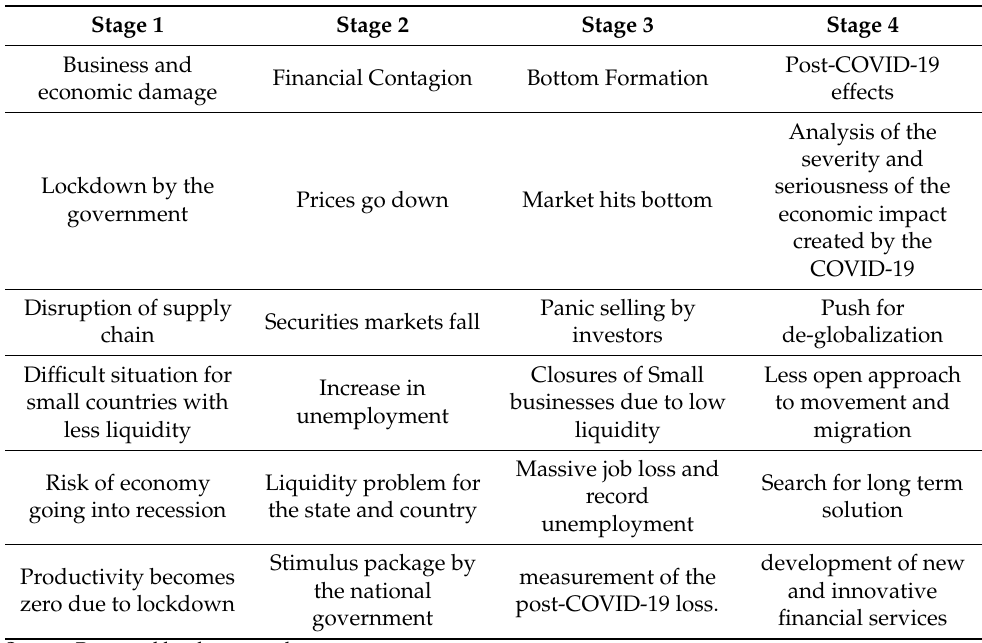
Table 1. The four-stage economic Impact of